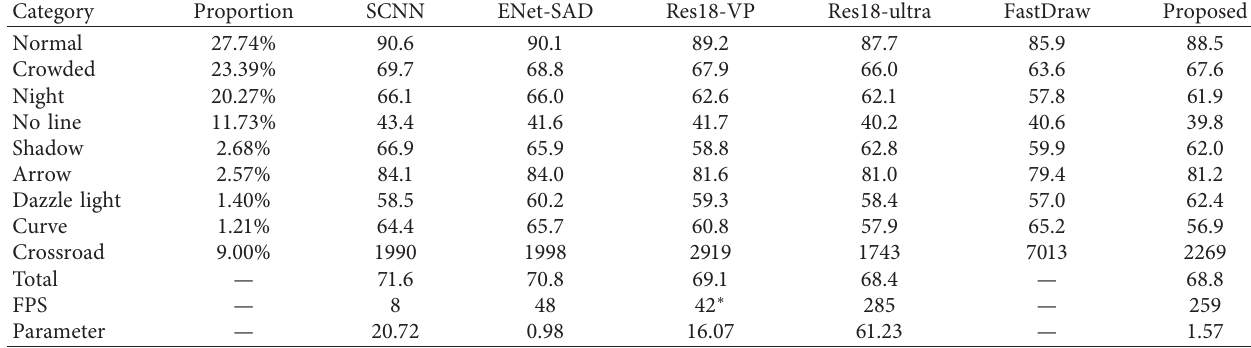
Table 3: Comparison with state-of-the-art methods on CULane dataset with IoU threshold � 0.5. Use PyTorch to test FPS and parameters at 3 ∗ 288 ∗ 800 resolution on NVIDIA RTX 2070s. Data with “ ∗ ” mark is obtained from the original